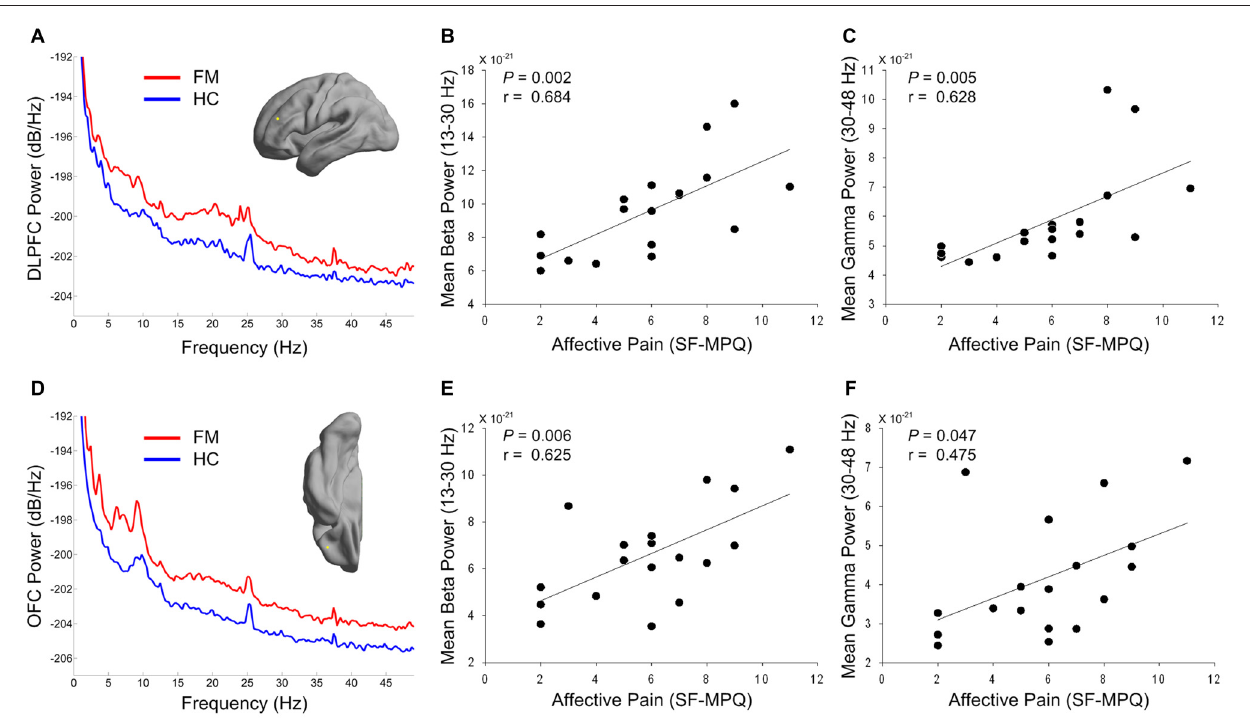
FIGURE 3 | Power spectrums of the prefrontal source activity (A,D) and relationship between affective pain intensity and high-frequency power of prefrontal regions in patients with FM (B,C,E,F) . The yellow dots in the cortical surface indicate the locations of the maximal difference in theta power in the DLPFC (A) and OFC (D) areas. Red and blue lines indicate grand averaged source power spectra for FM patients and HC subjects, respectively. Mean beta (B,E) and gamma (C,F) powers were calculated from the individual DLPFC (A) and OFC (D) source power spectra in FM patients. DLPFC, dorsolateral prefrontal cortex; OFC, orbitofrontal cortex; SF-MPQ, short-form McGill Pain Questionnaire; FM, fibromyalgia; HC, healthy